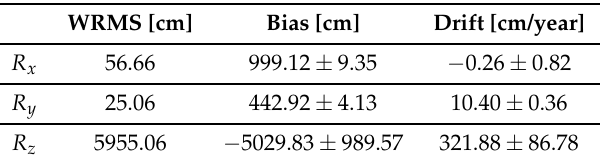
Table 1. The results derived from the RL06 CSR Stokes coefficients with monthly resolution. WRMS after fitting a linear function to each, biases, and drifts of the equivalent rotations R x , R y , and R z from ATRF to PAI. Units are (cm) and (cm/year), time origin is 2000.0.